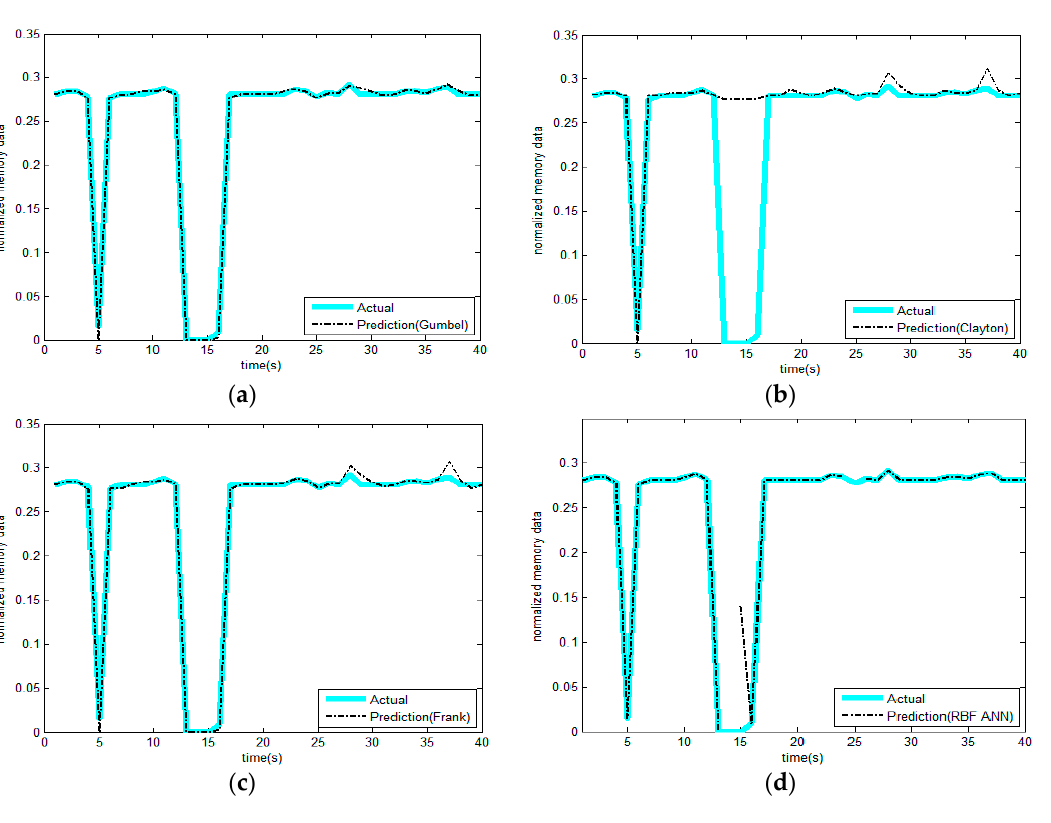
Figure 11. Comparison between predictive value and actual value of memory through four methods. ( a ) Gumbel-copula; ( b ) Clayton-copula; ( c ) Frank-copula; ( d ) RBF-ANN. In order to further test the performance of the proposed model, we used R-square (R 2 ) and root mean squared error (RMSE) to depict the difference between them. The “deterministic coefficient”